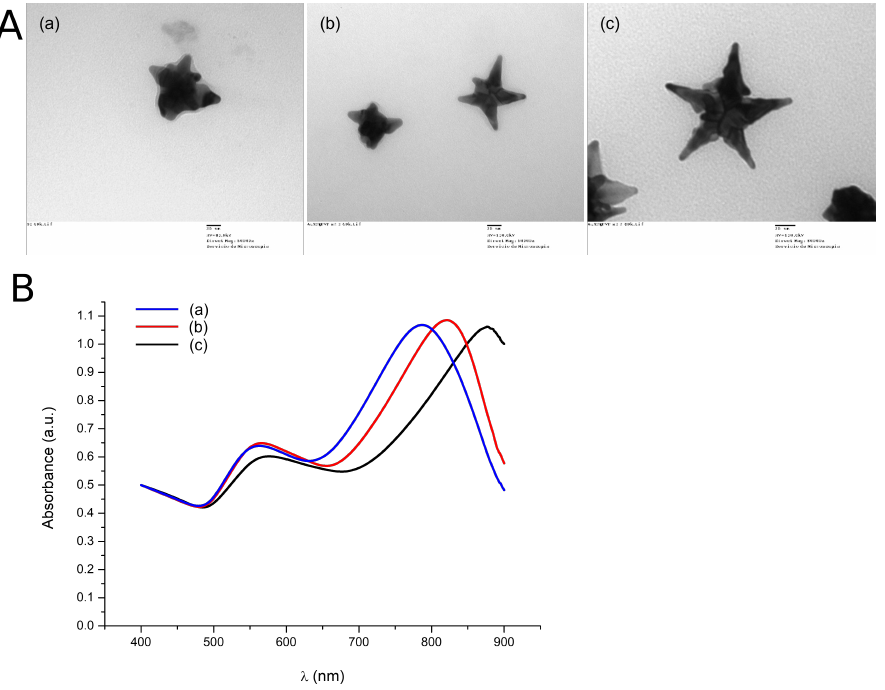
Figure 7. ( A ) NanoStar morphologies from three different syntheses with different tip lengths from shorter (a) to longer (c) and ( B ) Measured absorption spectrums corresponding to the synthesis of the